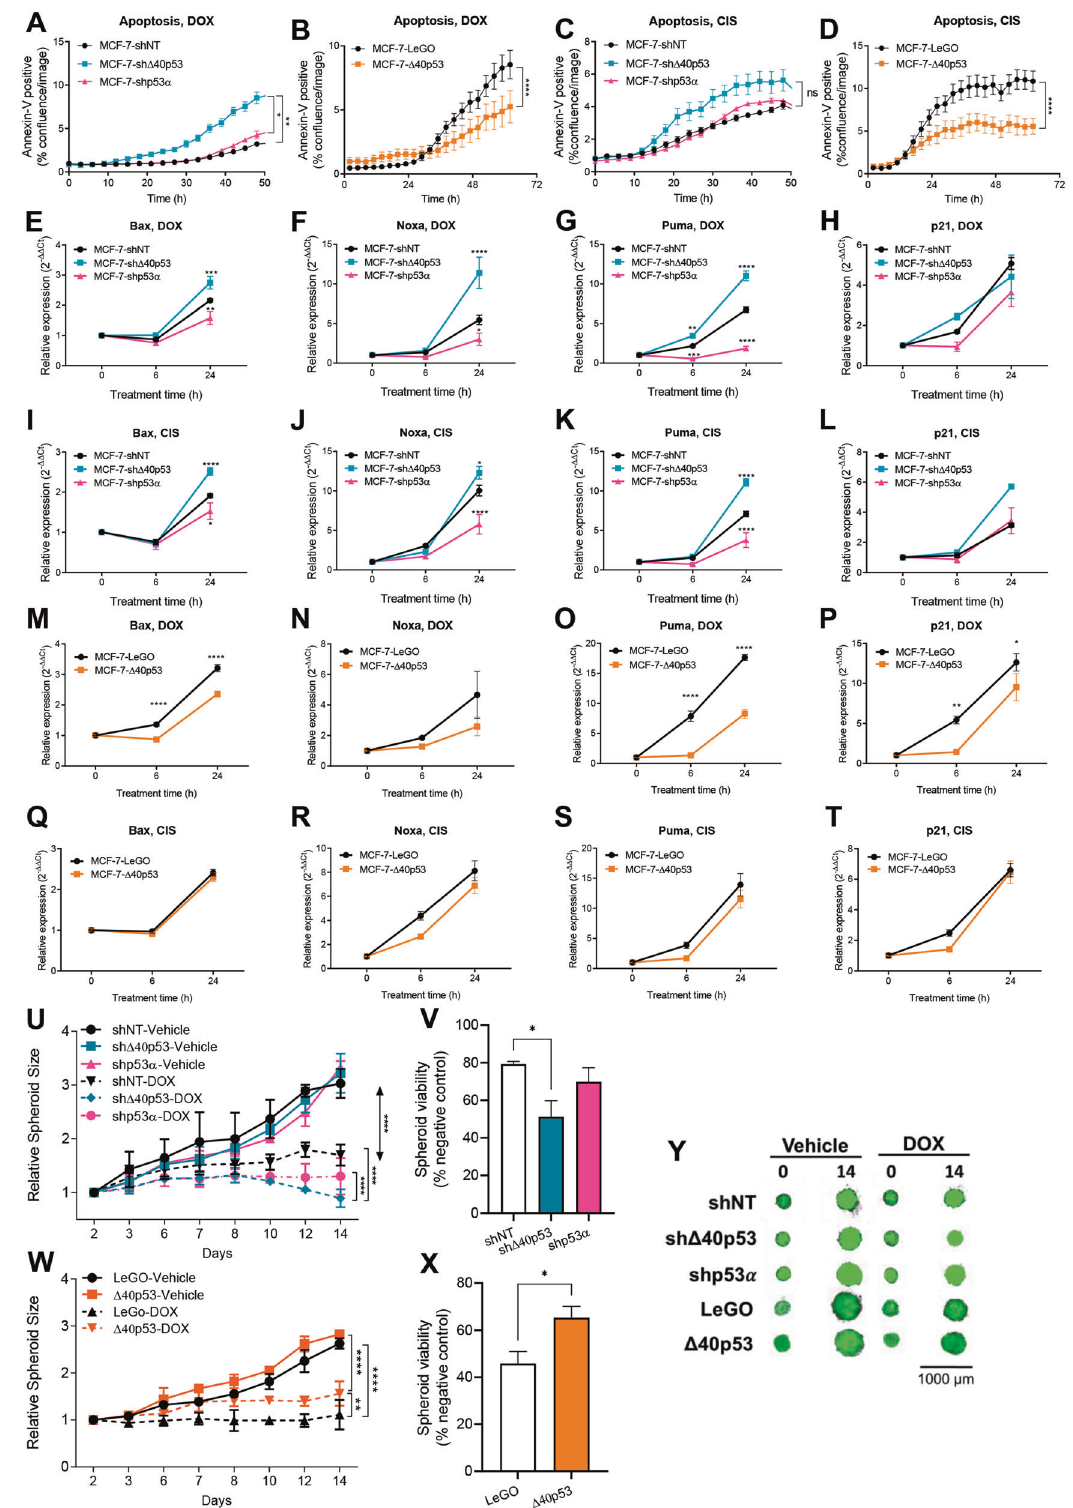
expression of BRCA1 ( p = 0.0077) and RAD51 ( p = 0.0018) was also observed in MCF-7- Δ 40p53 cells after treatment when compared to the LeGO subline (Fig. 6B, C). In contrast, knockdown of Δ 40p53 had no signi fi cant effect on the expression of RAD51 or BRCA1 (Fig. 6B, C). After 3 h of DOX treatment, p53 α was shown to co-localise with BRCA1 (Supplementary Fig. 6A, B) and RAD51 Cell Death and Disease (2022)